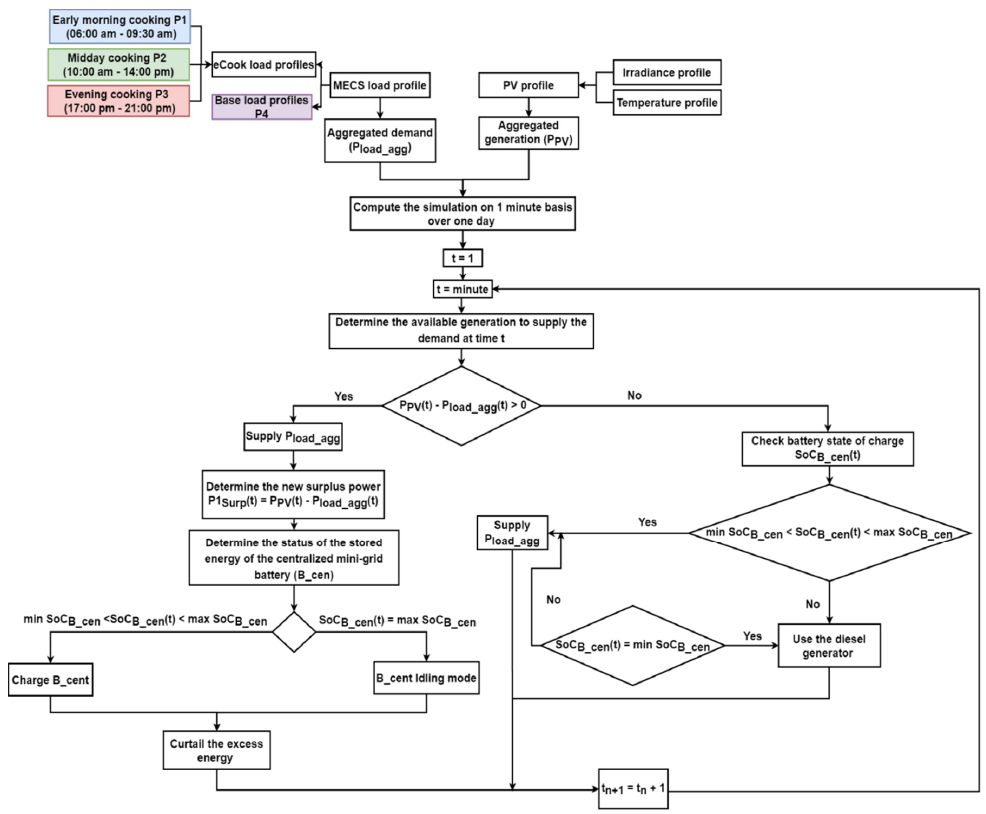
Figure 7. Load following energy dispatch strategy flowchart.